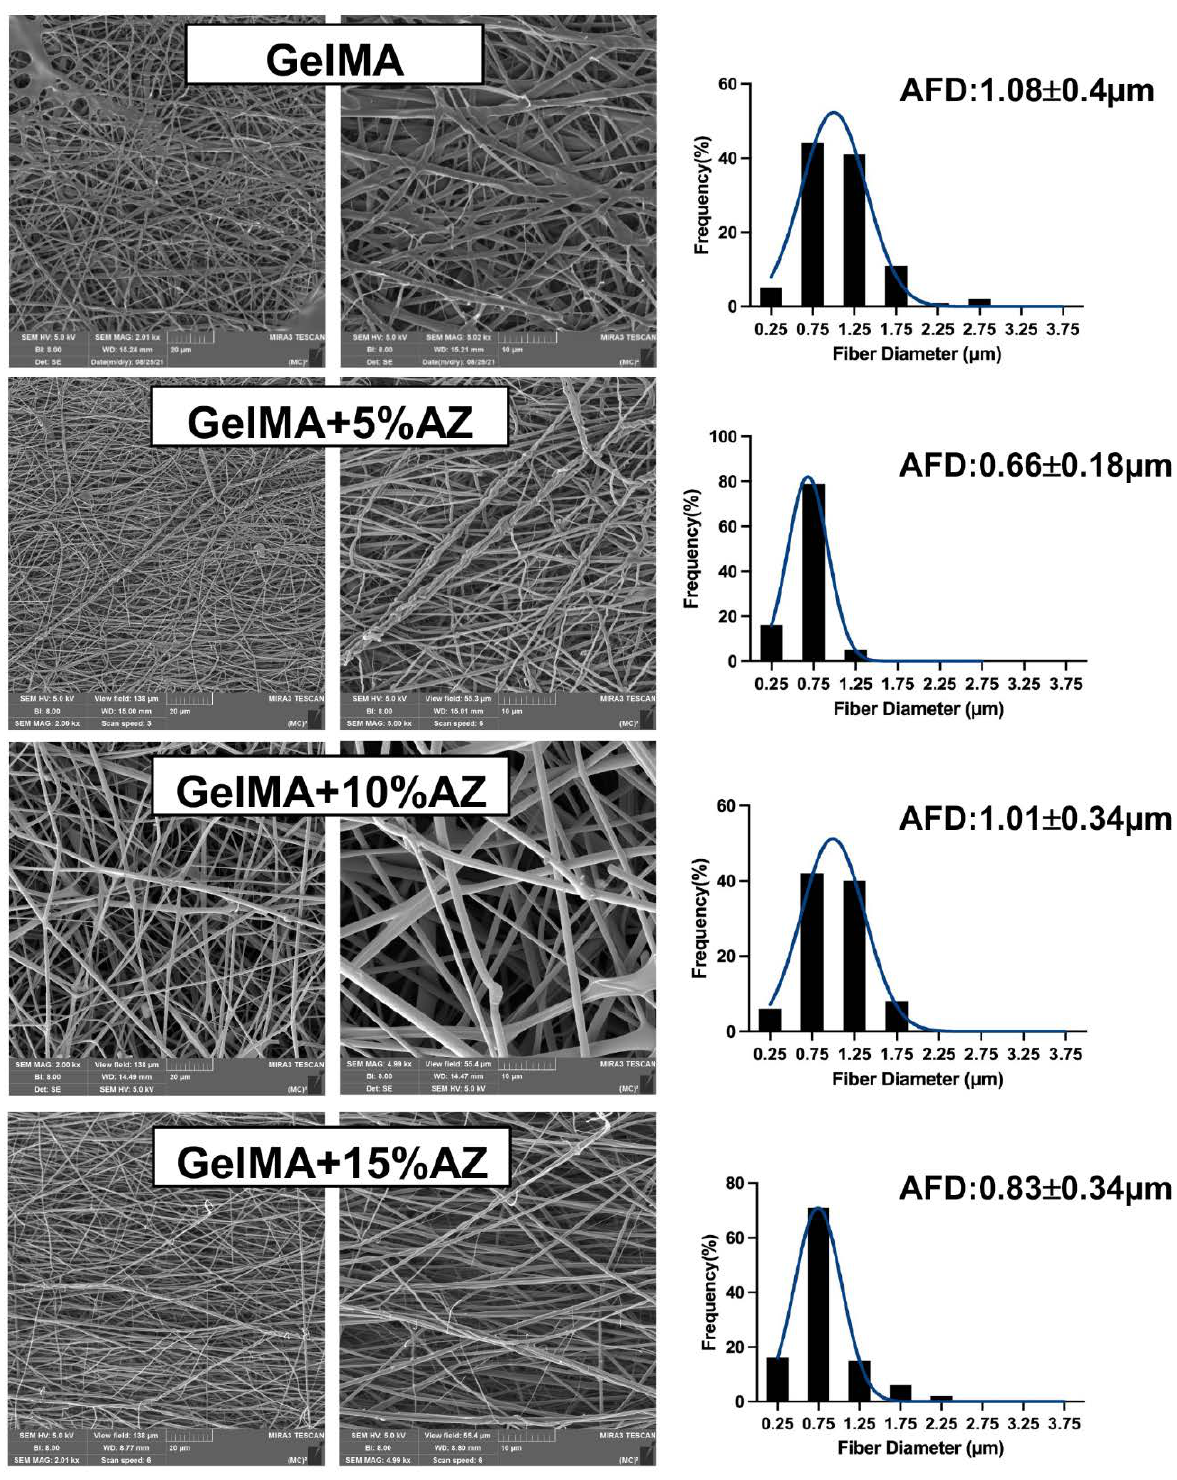
Figure 1. ( Left ) Representative scanning electron microscopy (SEM) images of the electrospun azithromycin-laden gelatin methacryloyl and the pure (antibiotic-free) GelMA fibers. ( Right ) Histograms showing the fiber diameter frequency and average fiber diameter (AFD) with standard